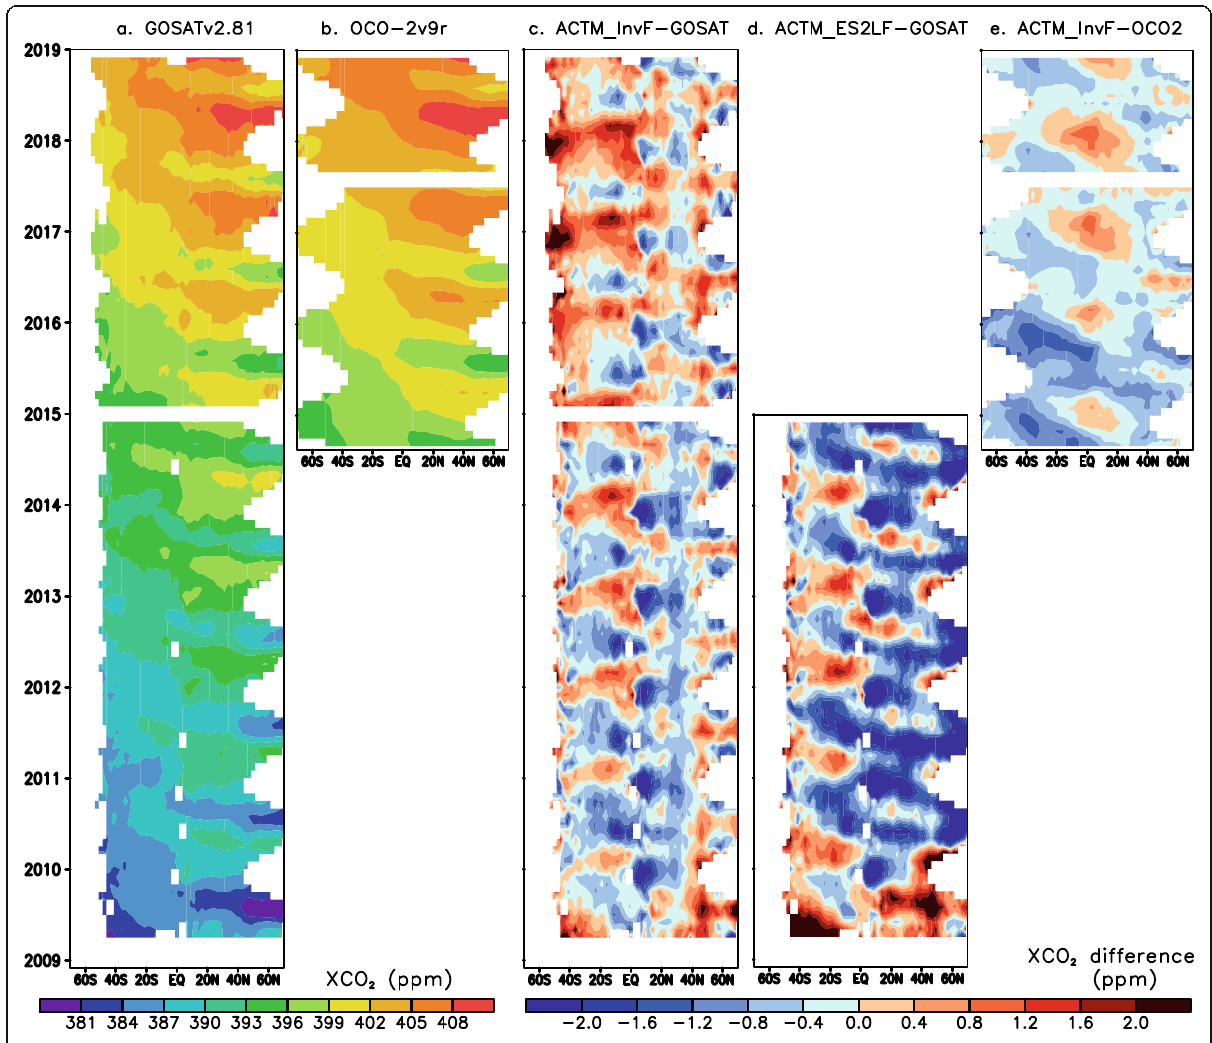
Fig. 5 Time evolution of zonal mean meridional gradients of XCO 2 as measured by GOSAT, OCO-2 in comparison with two ACTM_InvF and ACTM_ES2LF simulations. The plots by using data over land only and water only are shown in Fig. S1 and Fig. S2,